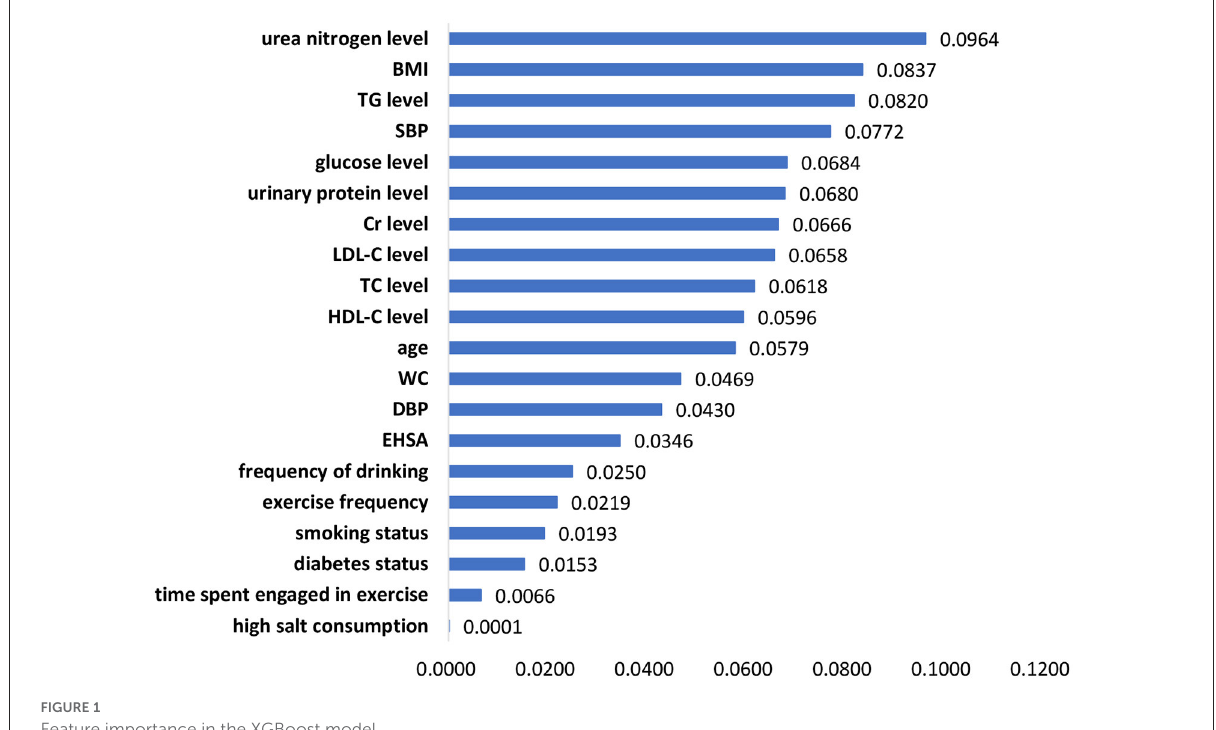
FIGURE1 Feature importance in the XGBoost model.